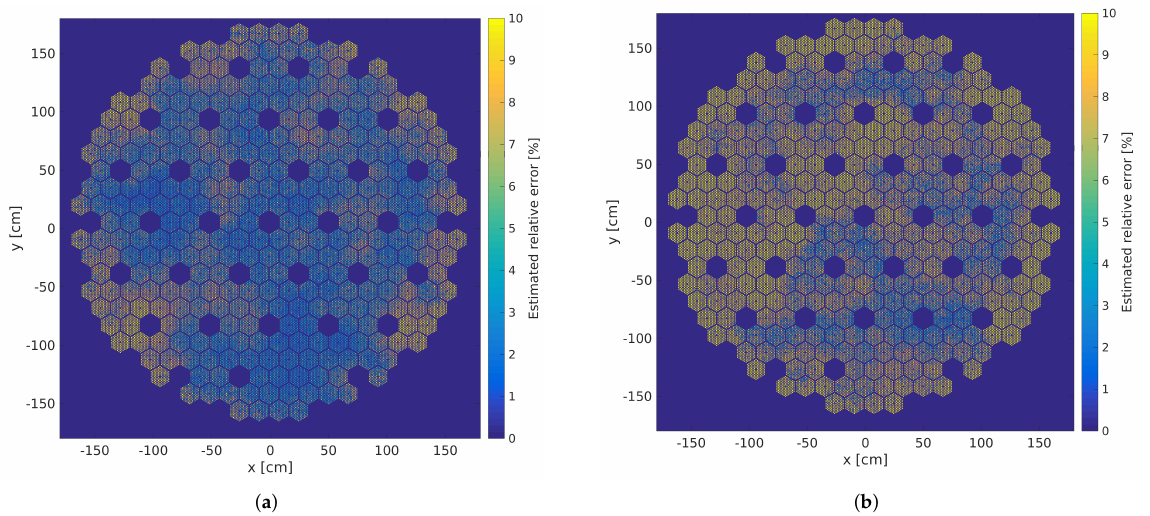
Figure 14. Pin-wise relative error distribution for middle nodes ( a ) and topmost nodes at the end of the transient, t = 13.8 s ( b